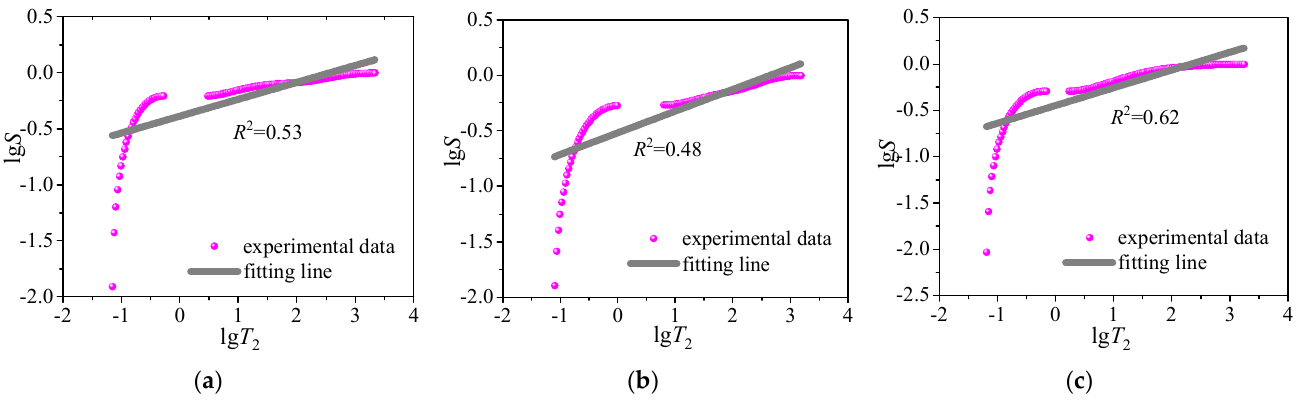
Figure 6. Log–log fitting results for the entire pore size range, based on NMR. ( a ) N1, ( b ) N2, and ( c ) N3.